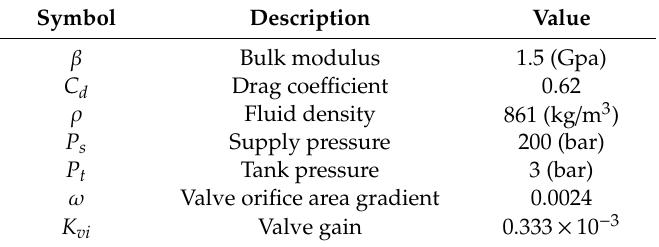
Table 1. Parameters of the hydraulic specification.